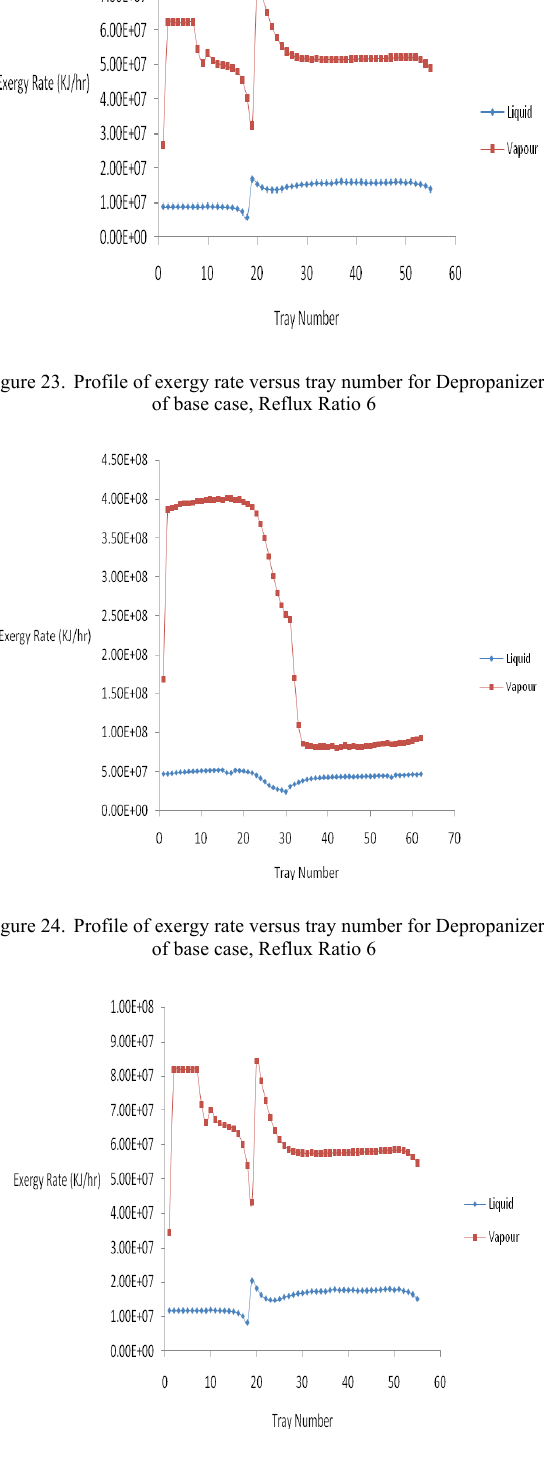
Figure 25. Profile of exergy rate versus tray number for Depropanizer of base 1200KPa Case